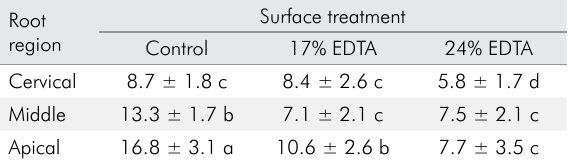
Table 3. Mean values and standard deviation of microhardness (Vickers) for self-adhesive resin cement RelyX™ U200.